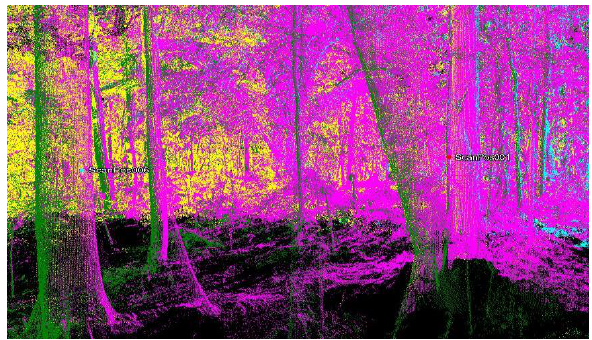
Figure 2. Registered point cloud data from four scan positions of a sample plot is shown with different